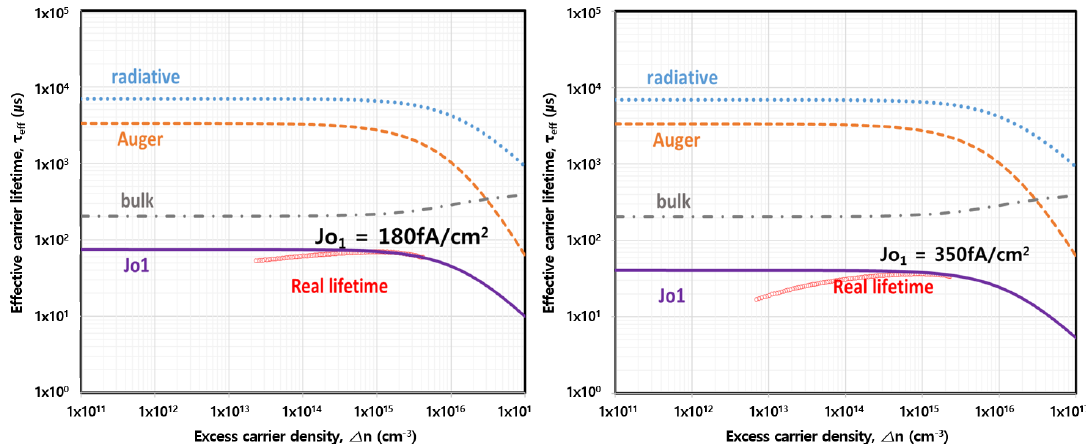
Figure 6. Fill factor loss analysis results of PERC B: ( a ) Normalized fill factor ratio; ( b ) Absolute fill factor loss.